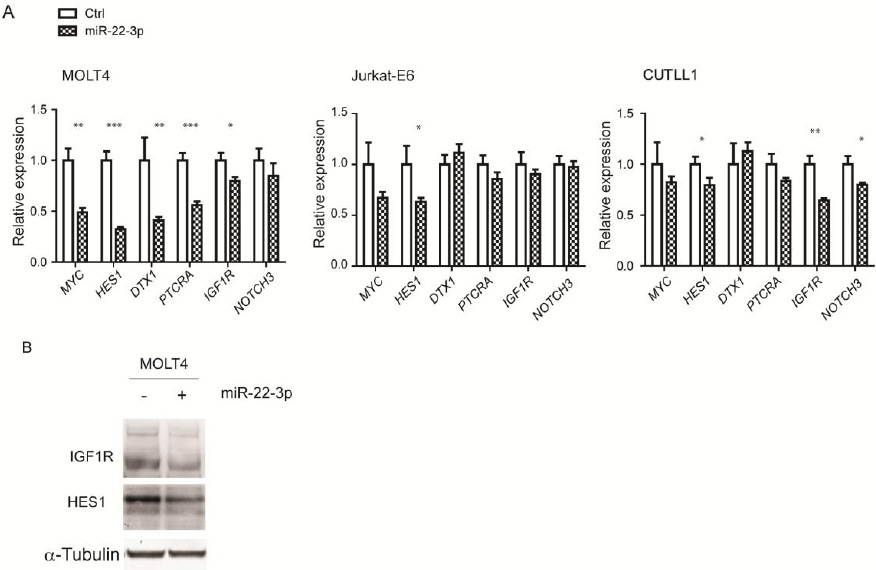
Figure 5. miR-22-3p overexpression in T-ALL cells leads to the downregulation of multiple NOTCH1 targets. ( A ) qPCR analysis of human MYC, HES1, DTX1, PTCRA IGF1R, and NOTCH3 in MOLT4, Jurkat-E6, and CUTLL1 cells engineered to stably express miR-22-3p or empty vector (Ctrl) (* p < 0.05, ** p < 0.01, and *** p < 0.001). ( B ) Western blot analysis of HES1 and IGF1R in MOLT4 cells overexpressing miR-22-3p. α-Tubulin was used as loading control. Data are represented as mean ± SD.